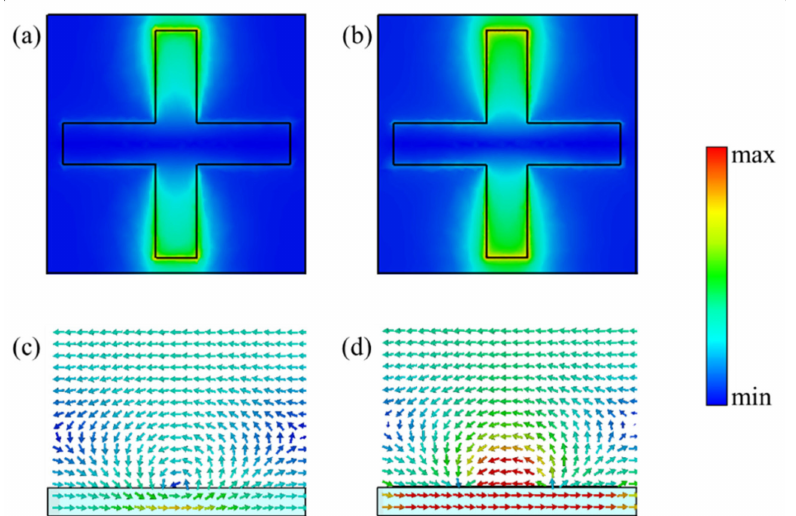
Figure 5. Simulated amplitude distribution of the electric field in reflection mode with ( a ) µ c = 0 eV, λ = 6.8 µ m and ( b ) µ c = 0.12 eV, λ = 6.8 µ m. Simulated cross-section magnetic field distribution in